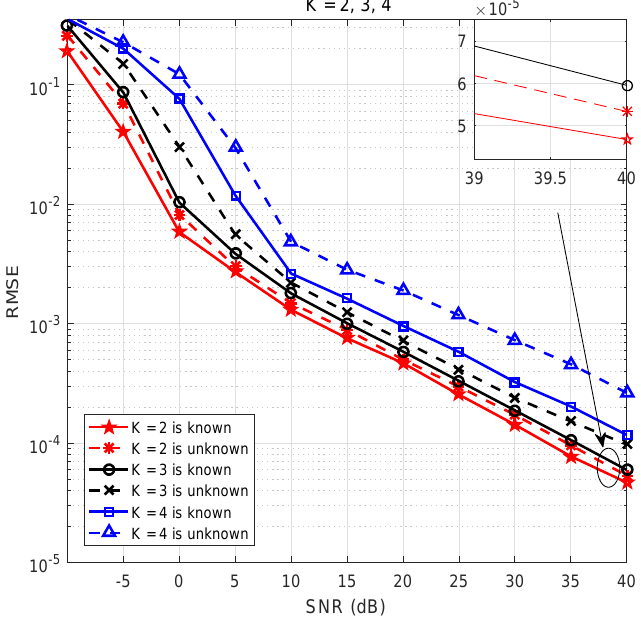
Figure 5. RMSE performance of the proposed ISR-S method for different target numbers, represented by K